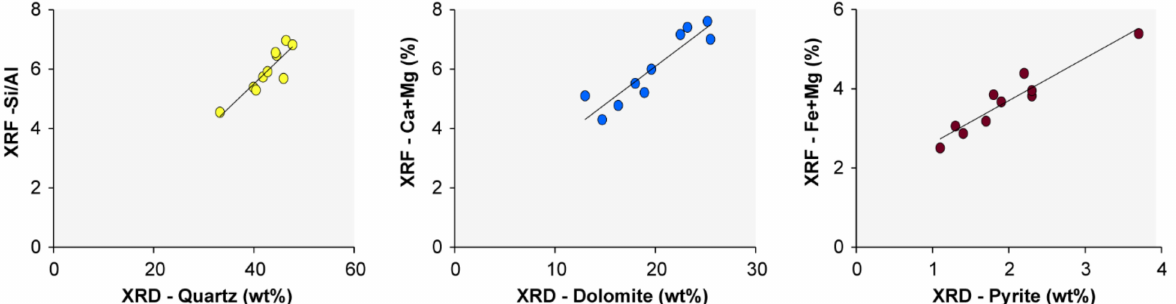
Figure 7. Cross plots between selected minerals (XRD) and elemental proxies (XRF) for ten drill cutting samples. Calcium plus magnesium (Ca+Mg) can be used as a proxy for dolomite, the silicon to aluminum ratio (Si/Al) for quartz, and iron plus sulfur (Fe+S) for pyrite contents. The XRD mineralogy and XRF analyses were performed on the exact same pulverized